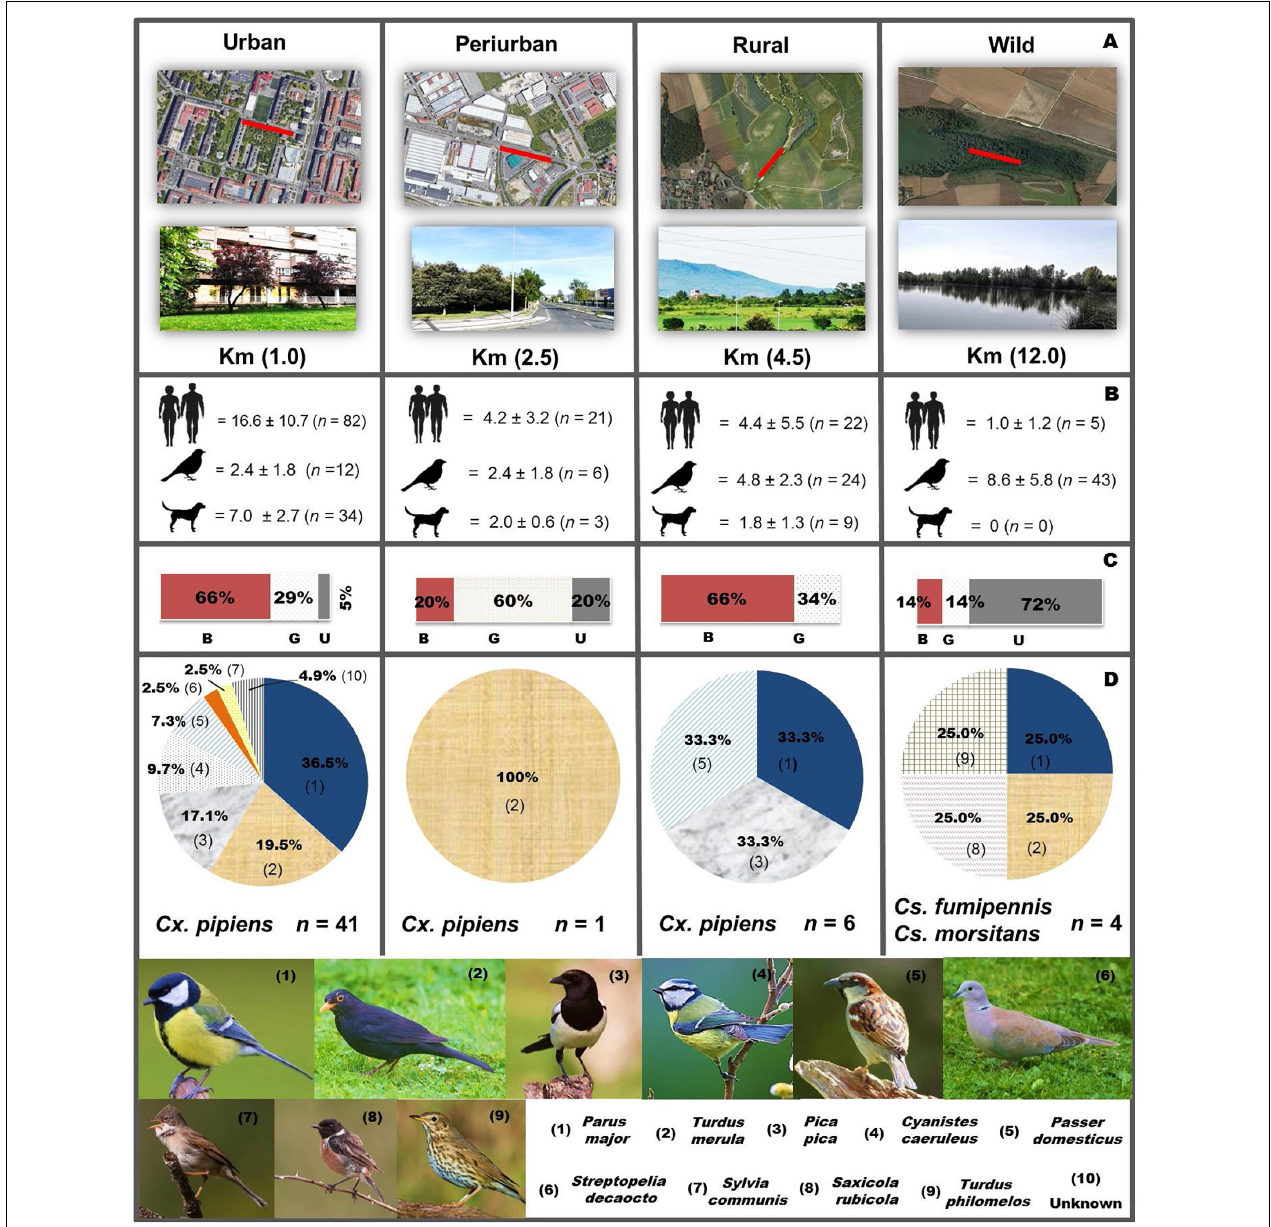
FIGURE 1 | Summary of sampling sites and host blood-meal sources for Cx. pipiens and Culiseta spp. (A) Sampling habitats gradient (urban, periurban, rural, and wild) with dismissing degree of anthropogenic modification (NASA Google Earth images). Red continuous line within the colored image denotes the 100 m linear transect sampling area. The images below show a general view of the sampled sites along with the distance (kilometers) from the city center. (B) Mean ( ± SEM) host abundance of humans, birds and dogs ( n = total host abundance) recorded across sampling period. (C) Proportion of blood-engorged (B), gravid (G), and unfed (U) females in each habitat. (D) Host blood meal sources for mosquitoes collected (numbers in parenthesis refer to host species showed below; n = successful blood meals